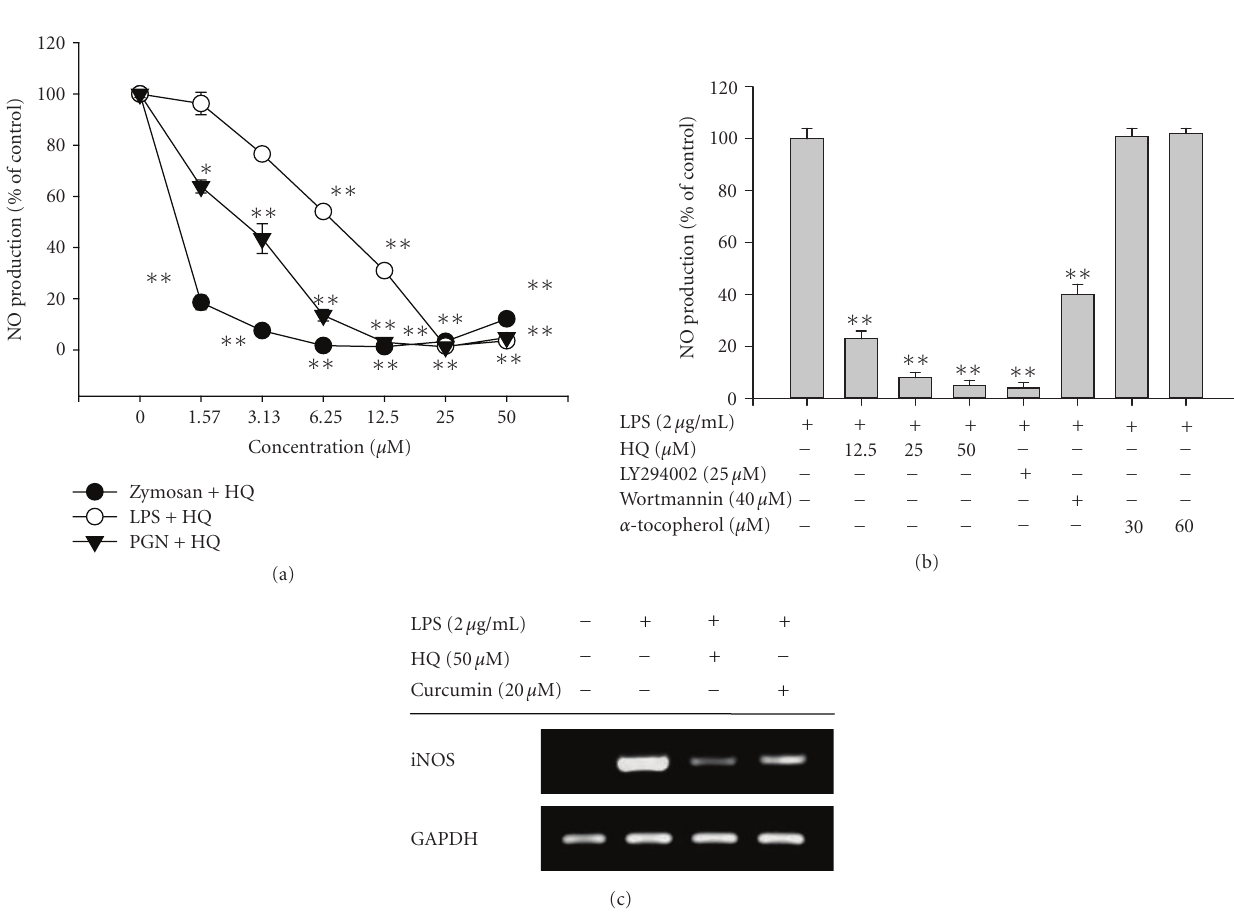
Figure 3: E ff ects of hydroquinone on the production of NO in LPS-treated RAW 264.7 cells or peritoneal macrophages. (a) and (b) RAW264.7 cells or peritoneal macrophages (1 × 10 6 ) were pretreated with various concentrations of HQ (hydroquinone) in the presence or absence of LPS (2 μ g/mL), PGN (10 μ g/mL), or zymosan (400 μ g/mL) for 24 hours. The level of NO was determined by Griess reagent as described in Section 2. (c) The mRNA levels of proinflammatory cytokines from RAW264.7 cells were determined by semiquantitative RT-PCR. The results show one representative experiment of three. ∗ p < . 05 and ∗∗ p < . 01 represent significant di ff erence as compared to